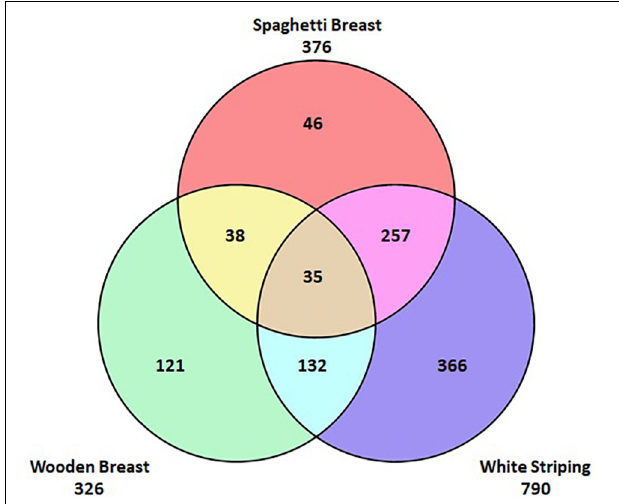
FIGURE 2 | This venn diagram demonstrates the incidence of the myopathies in 995 myopathy affected fillets. It can be seen that the myopathies can occur individually or be comorbid with each